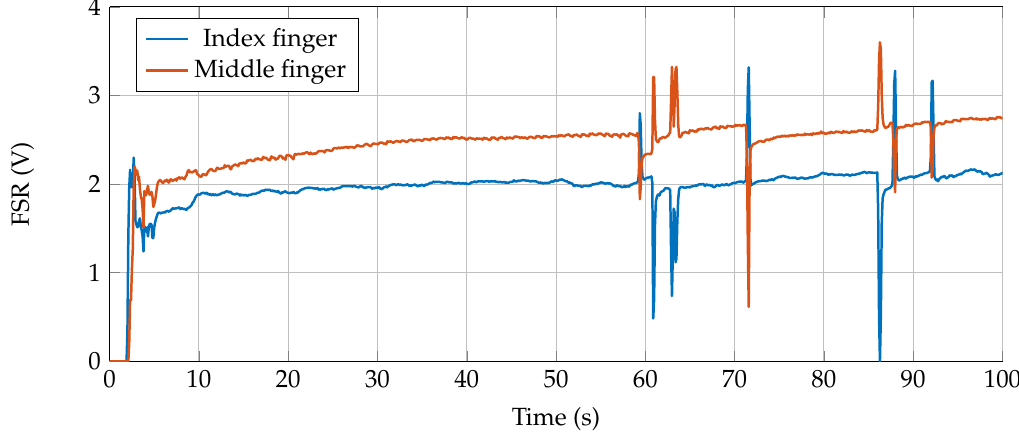
Figure 12. Index and middle finger are put on the keyboard alternative around 2s and stay stationary up to 59s. Subsequently, multiple keystrokes are executed. The stationary phase in the beginning shows a drift of the FSR values that adds to the approximately constant load of the fingers. A keystroke results in a positive spike of the corresponding FSR value and a drop of the other signal due to slightly releasing pressure with the resting finger.